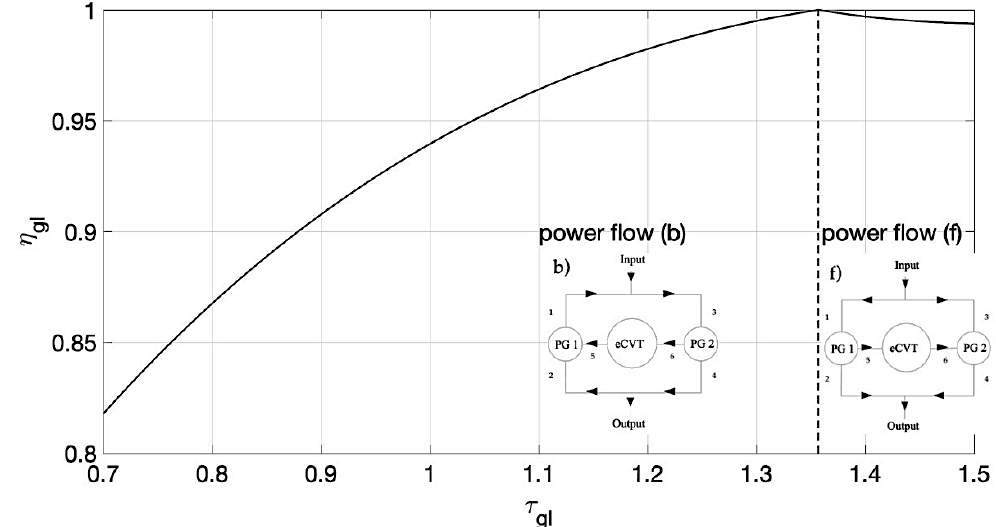
Figure 7. Global efficiency vs. global transmission ratio, given the input design parameters of Equations (28) and (29).